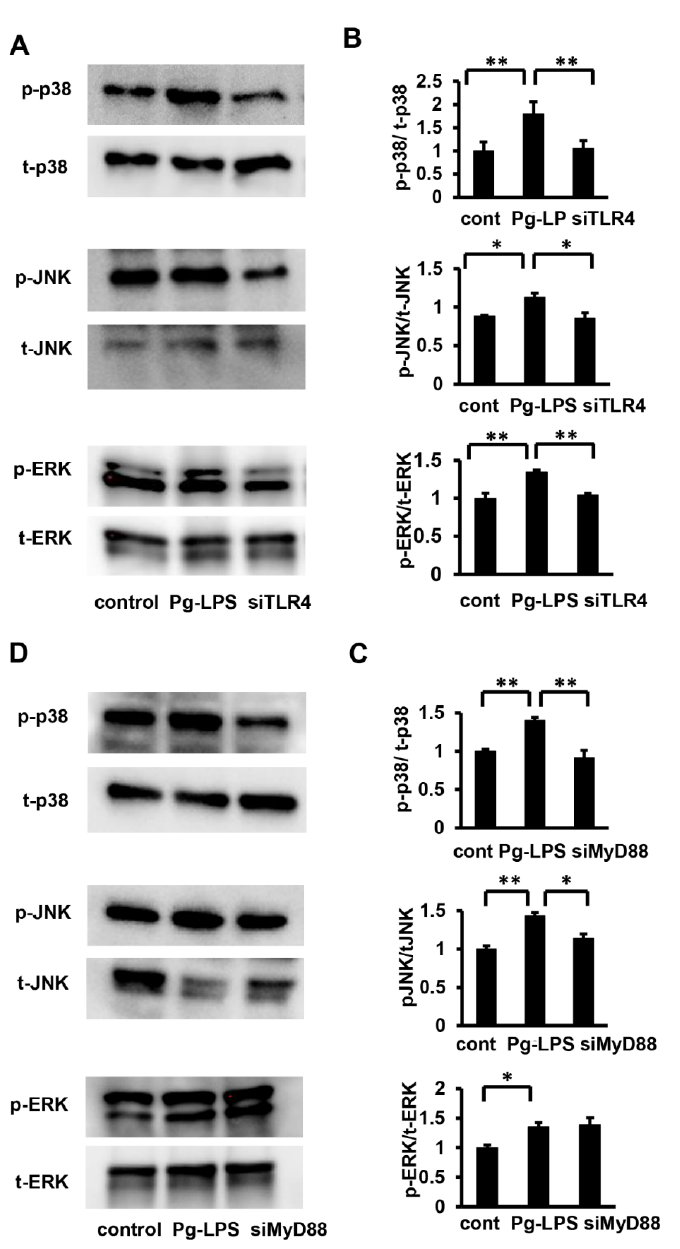
Figure 6. TLR4 knockdown suppresses p38 MAPK, SAPK/JNK, and ERK activation in Pg -LPS induced HASMCs, while Myd88 knockdown suppresses p38 MAPK and SAPK/JNK activation in Pg -LPS-induced HASMCs but not of ERK. ( A ) Phosphorylation of p38 MAPK, SAPK/JNK, and ERK after Pg -LPS treatment. TLR4 in HASMCs was knocked down (siRNA at 5 nM), and cells were evaluated using Western blot analysis for p38 MAPK, SAPK/JNK, and ERK phosphorylation levels, 5 min after Pg -LPS treatment (100 ng/mL). Representative blots are shown. ( B ) Quantitative analysis of the p38 MAPK, SAPK/JNK, and ERK phosphorylation levels. TLR4 knockdown suppressed phosphorylation levels of Pg -LPS-induced p38 MAPK, SAPK/JNK, and ERK. n = 5 in each group. ( C ) Phosphorylation of p38 MAPK, SAPK/JNK, and ERK after Pg -LPS treatment. MyD88 in HASMCs was knocked down (siRNA at 5 nM), and cells were evaluated using Western blot analysis for p38 MAPK, SAPK/JNK, and ERK phosphorylation levels, 5 min after Pg -LPS treatment (100 ng/mL). Representative blots are shown. ( D ) Quantitative analysis of p38 MAPK, SAPK/JNK, and ERK phosphorylation levels. Myd88 knockdown suppressed phosphorylation levels of Pg -LPS-induced p38 MAPK and SAPK/JNK but not of ERK. n = 4 in each group. * p < 0.05 vs. basal; ** p < 0.01 vs. basal. Data are presented as mean ±